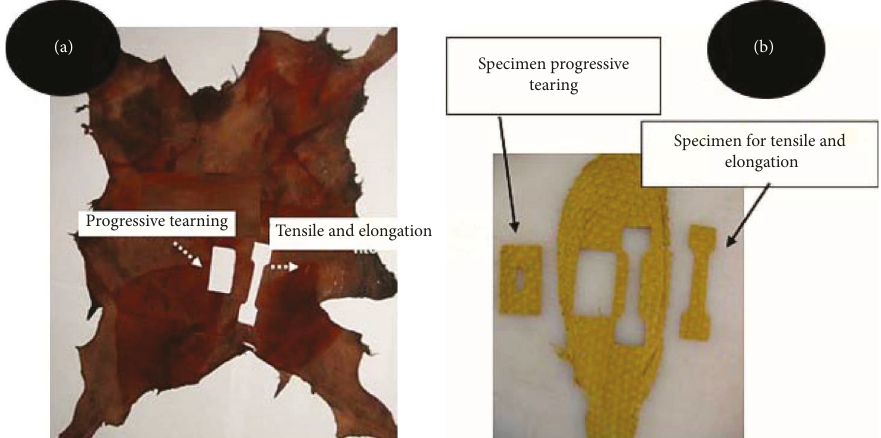
Figure 2: Position of specimen removal on rabbit (a) and Nile tilapia (b) leathers. Specimen for tensile and elongation; 1 � and specimen for progressive tearing test 2. Source: (a) Nascimento et al. [15] and (b)